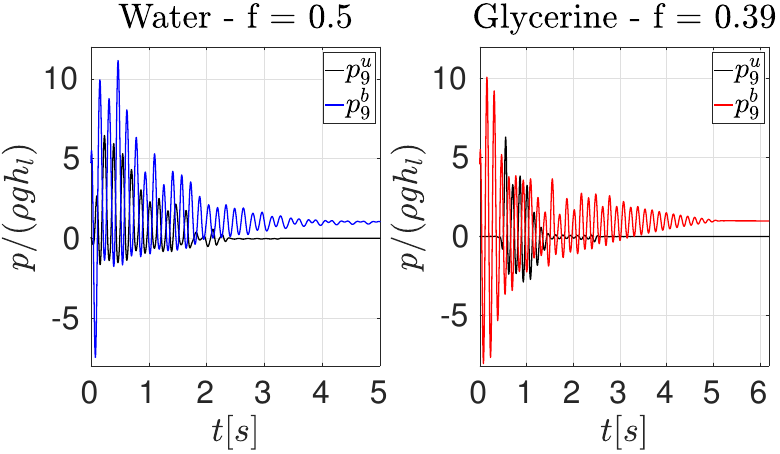
Figure 19. Normalized pressure signals at the top and bottom middle sensors (sensors p b the water and glycerine